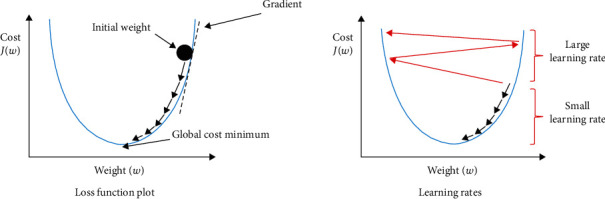
Hyperparameters of deep learning algorithm [41].